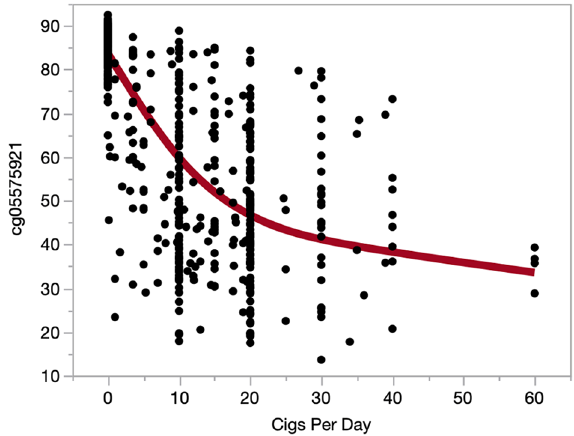
Figure 2. The relationship of WB cg05575921 methylation to self-reported daily cigarette consumption. The line in red represent a smoothing spline fit with a lambda of 100,000 ( p < 0.0001, R 2 = 0.6446).